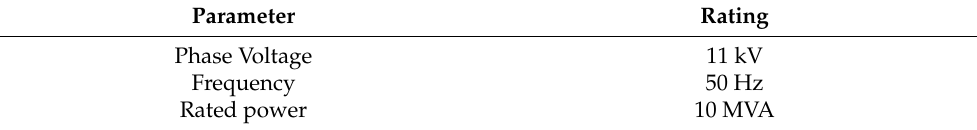
Table A8. Parameters of UG.